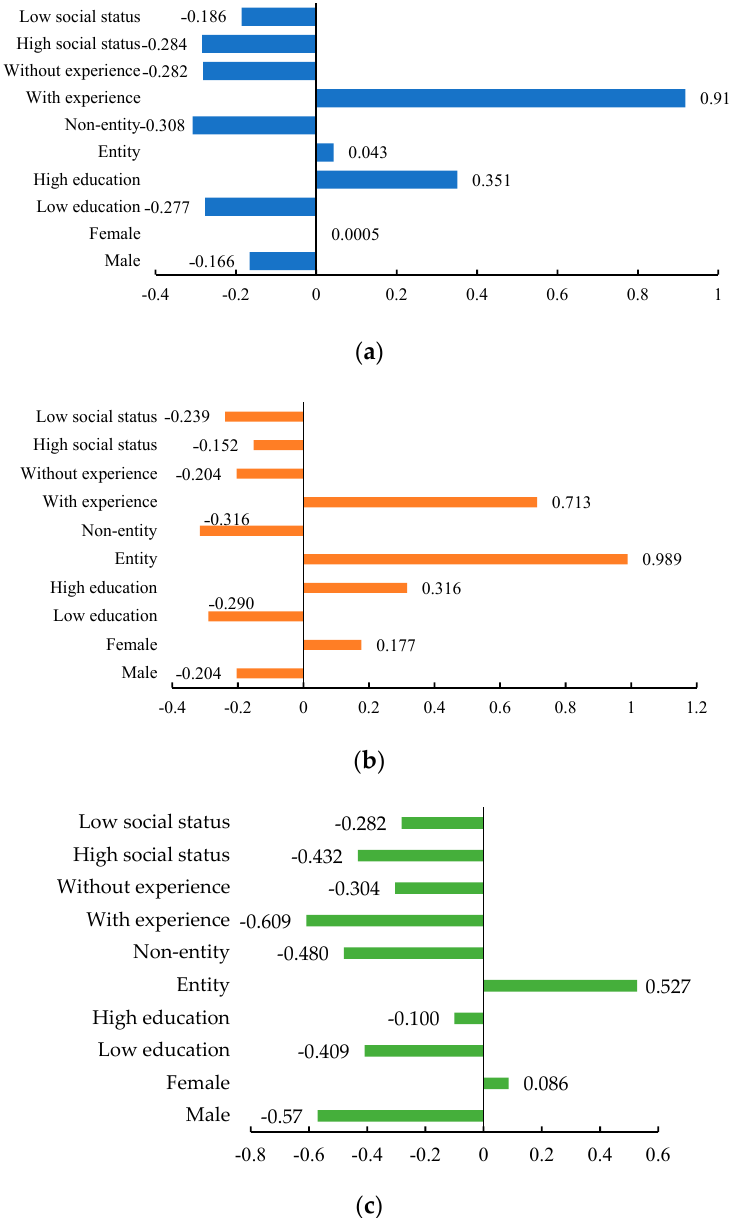
Figure 3. ( a ) The WTP of repayment across gender, education, agribusiness entity, loan experience, social status, and mean [95% confidence interval]. ( b ) The WTP of insurance across gender, education, agribusiness entity, loan experience, social status, and mean [95% confidence interval]. ( c ) The WTP of guarantee across gender, education, agribusiness entity, loan experience, social status, and mean [95% confidence interval].